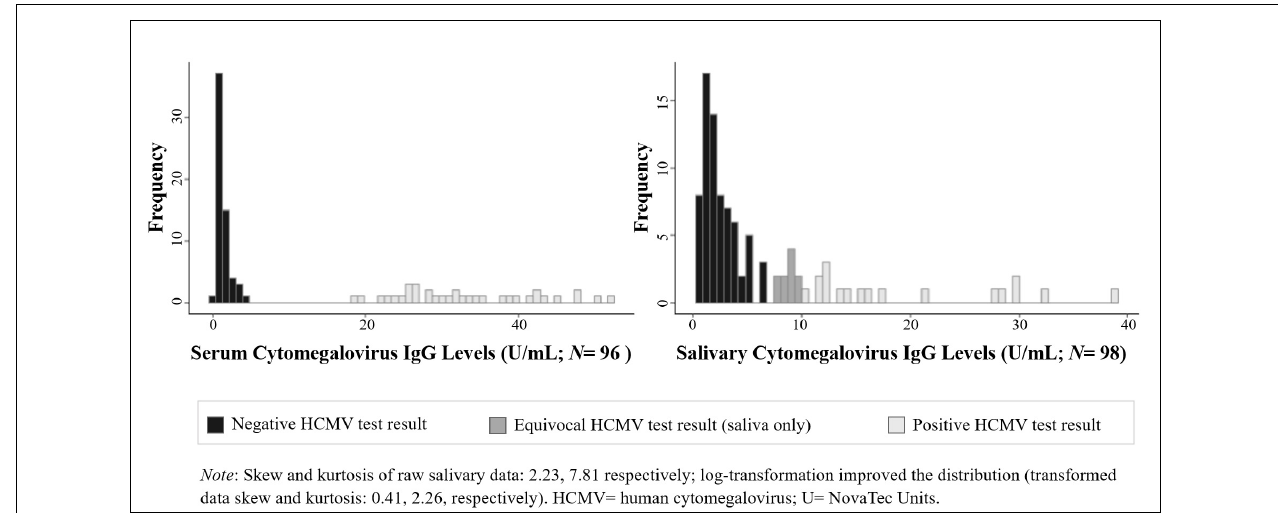
FIGURE 1 | Distribution of human cytomegalovirus (HCMV) IgG levels measured in serum and saliva from healthy adults. (Data are coded to represent HCMV test results within biospecimen